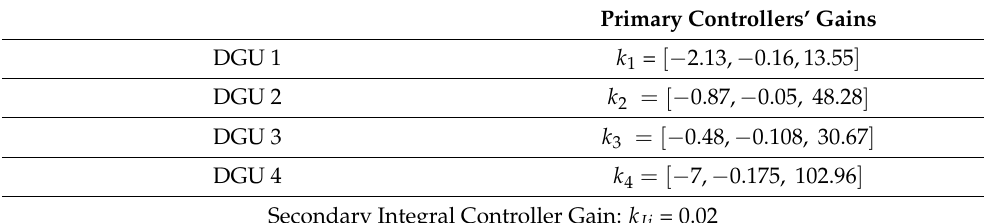
Table 3. Primary and secondary layer controller